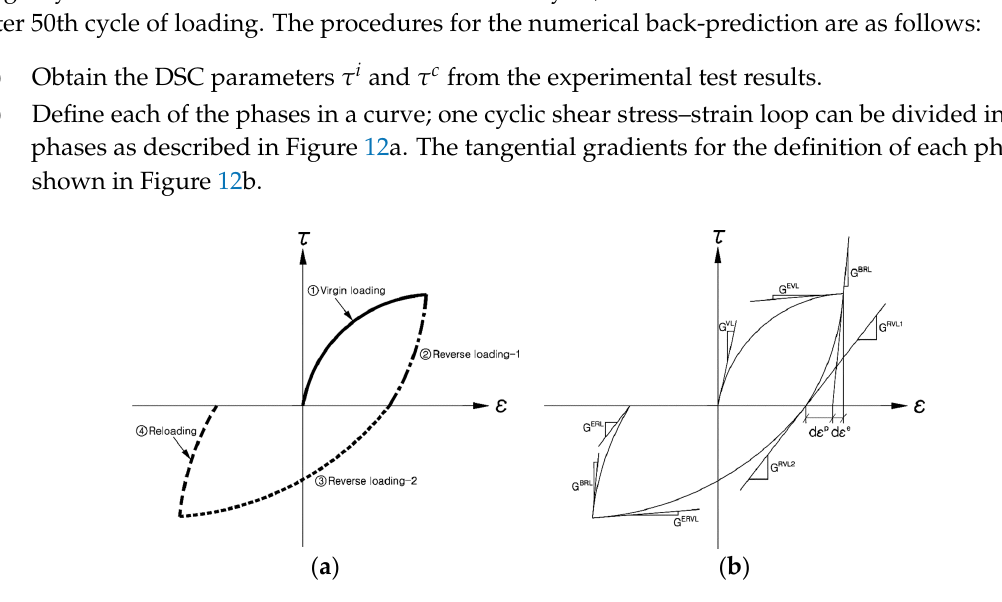
Figure 12. Definition of each phase in a curve: ( a ) four phases in a cyclic loading and ( b ) tangential gradients to define each phase [4].